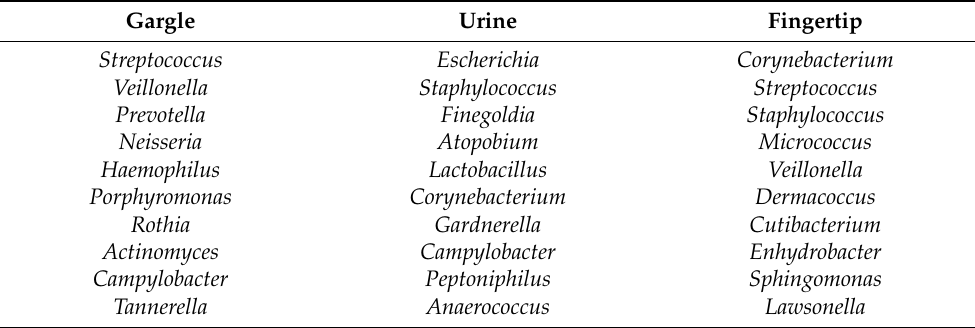
Table 2. Ten representative strains at the Genus level for each region, constructed using the micro- biome or indicative bacteria reported in previous studies and sample analysis conducted within the